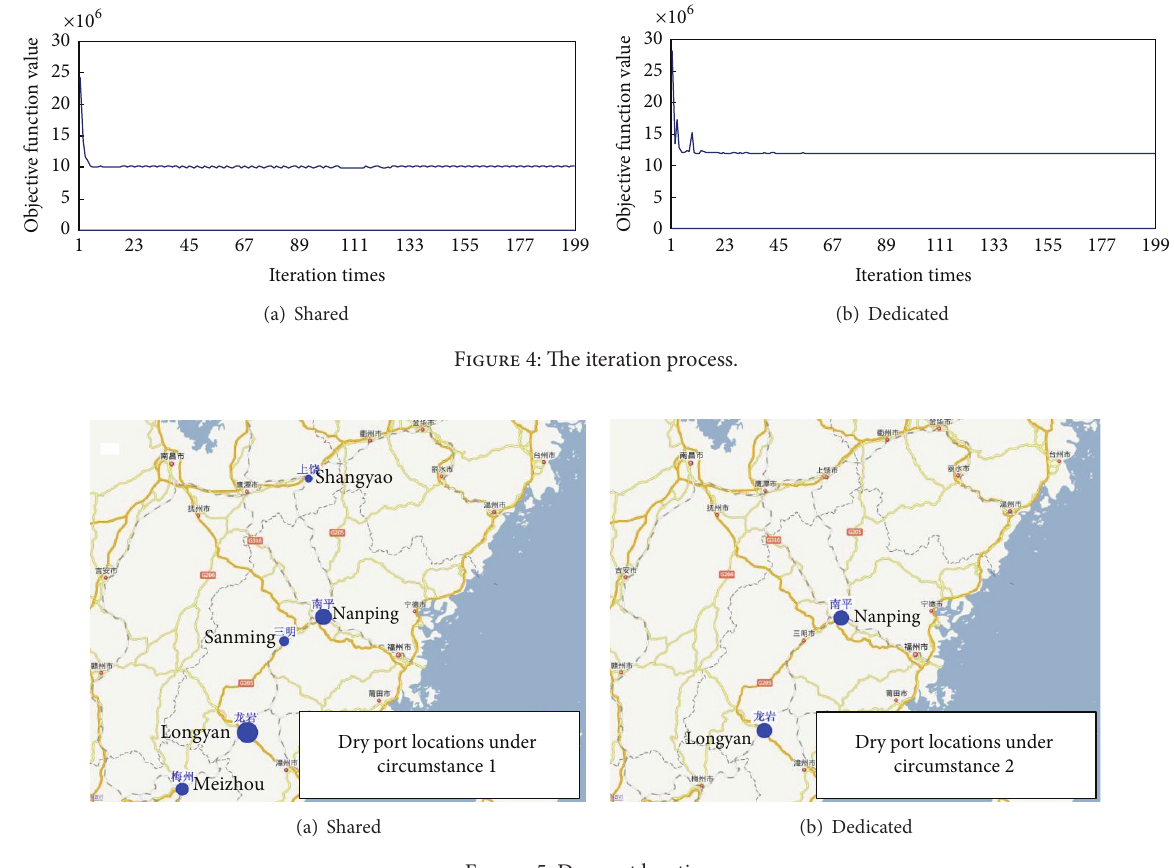
Figure 5: Dry port locations.